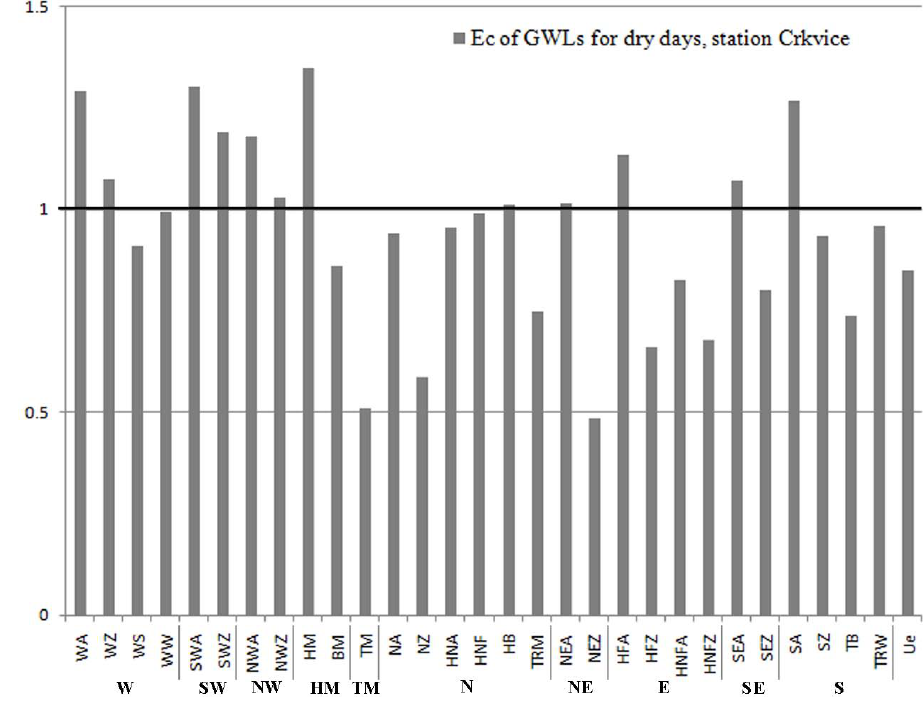
Fig. 6. The efficiency coefficient ( E c ) of GWLs for dry days in station Crkvice, period 1951–2007.